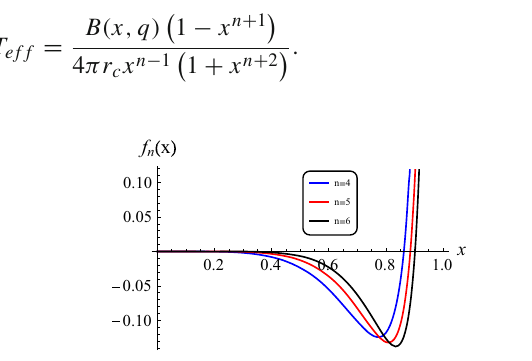
Fig. 1 f ( x ) − x diagram for diffrent n